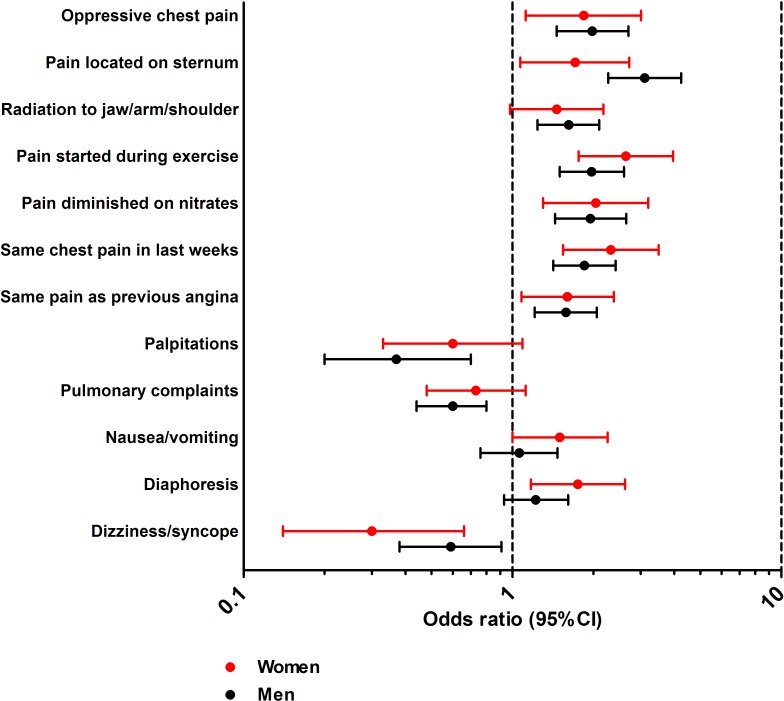
Univariable analysis (odds ratios) of all symptoms in women and men separately.